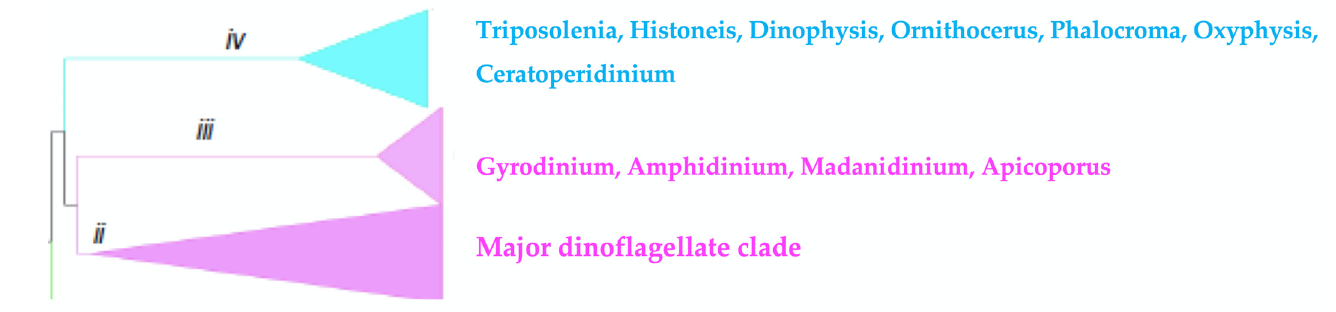
Figure 11. Enlarged view of Clade 3Aii, Clade 3Aiii, Clade 3Aiv.